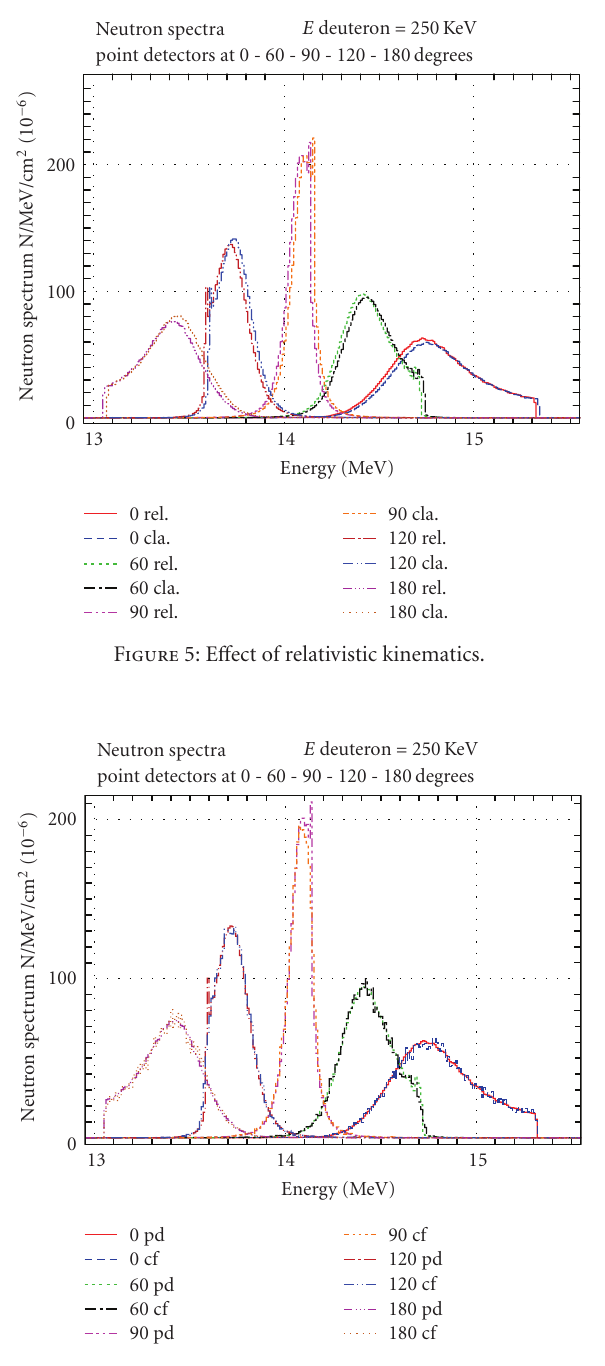
Figure 6: Comparison of D-T energy leakage spectra calculated with MCNP using both cell flux estimators and point